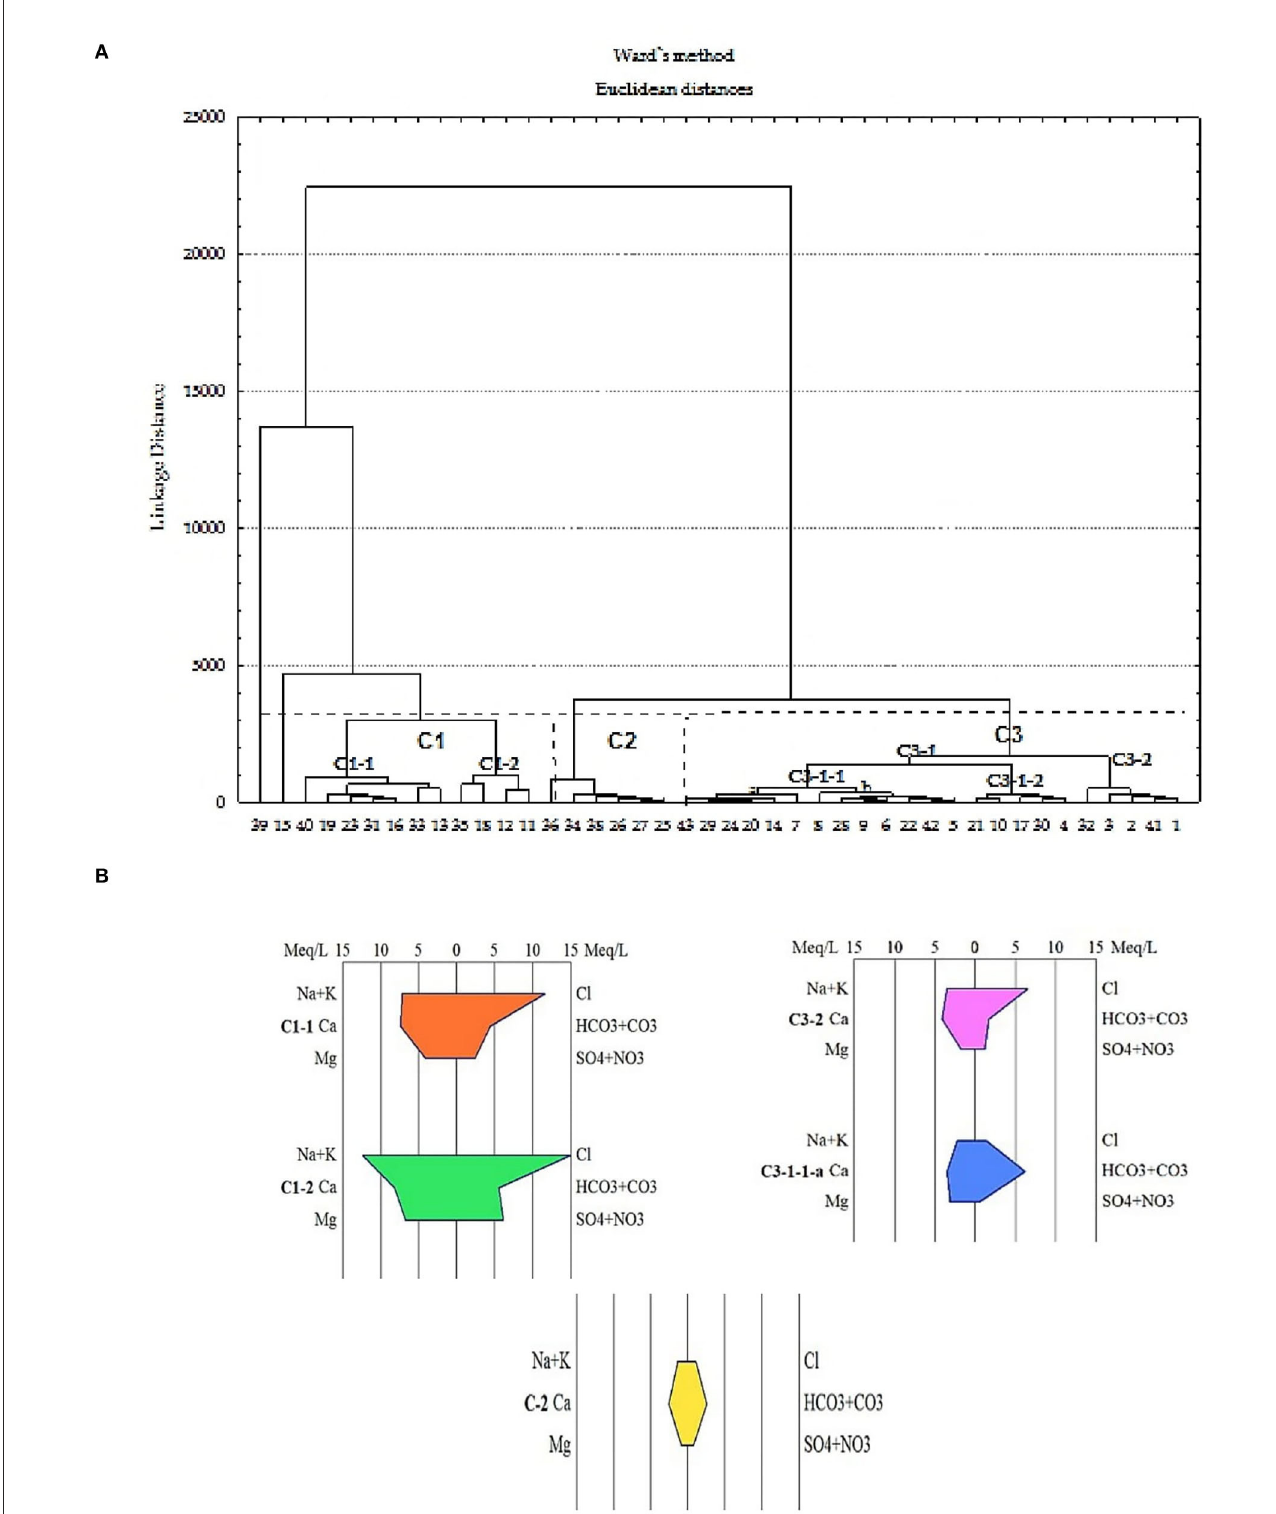
FIGURE6 Dendrogram (A) for the groundwater samples, showing the division into several clusters and Stiff diagram (B) showing the mean composition of groundwater in this cluster.